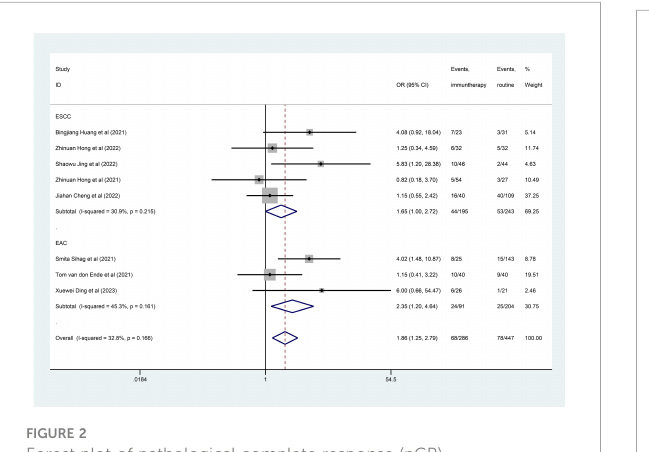
FIGURE 3 Forest plot of major pathological response